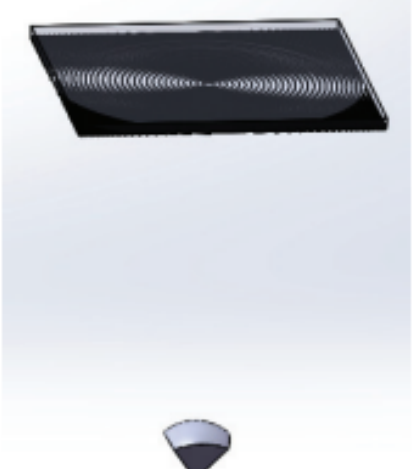
Figure 31. The CPV systems composed of the Fresnel lens and microprism [60]. Reprinted from